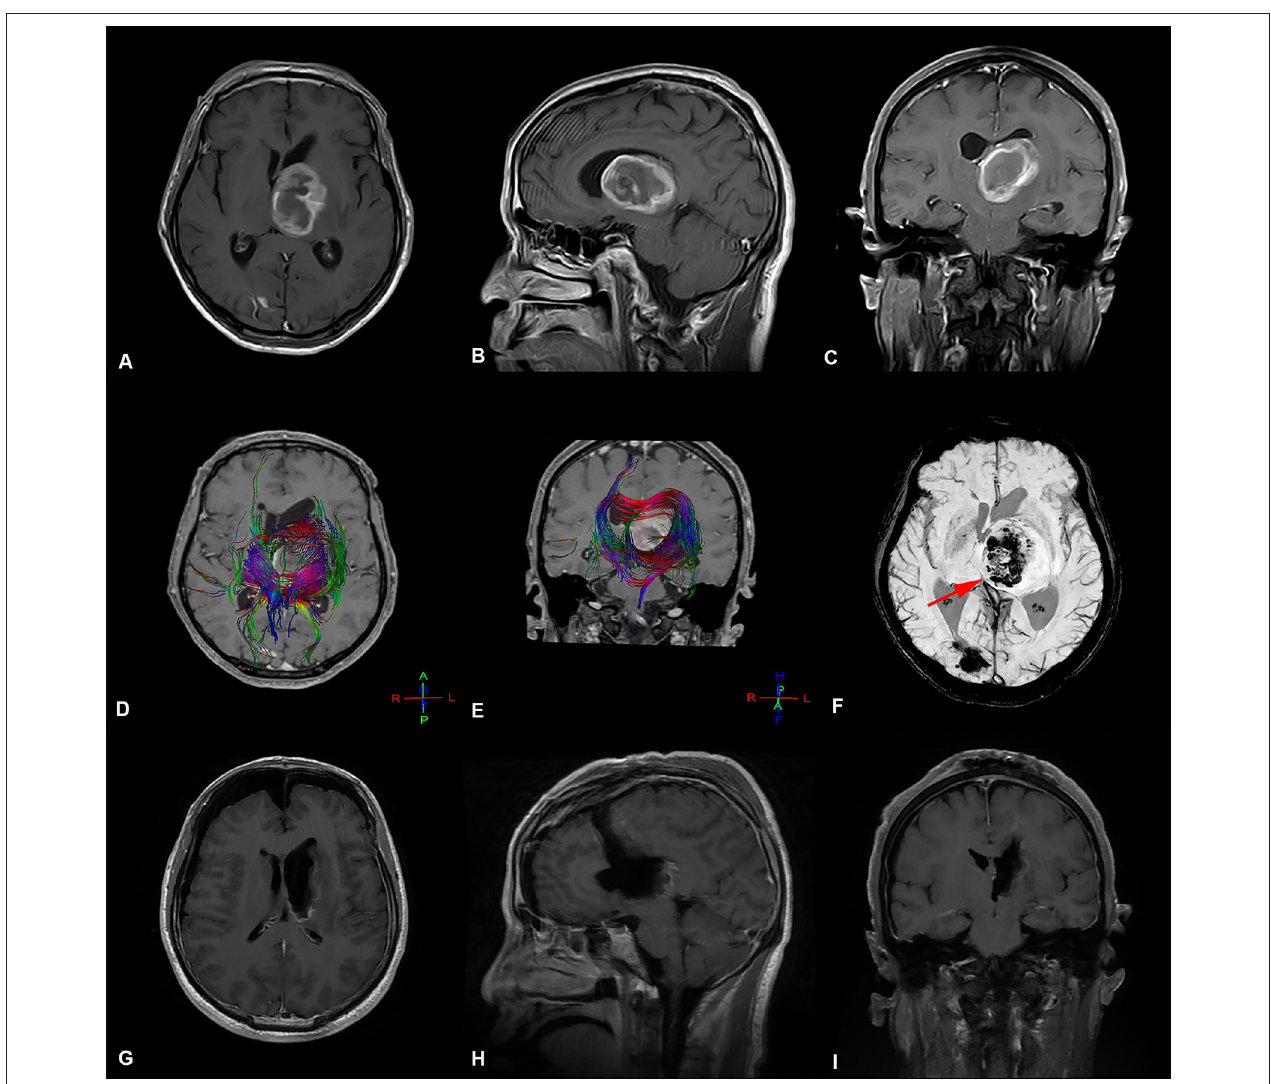
FIGURE 1 | Preoperative and postoperative imaging of thalamic malignant tumor resection with trans-frontal lateral ventricle approach. (A-C) display: Axial, sagittal, and coronal enhanced MRI of malignant tumors of the left thalamus. The main body of the tumor is located in the thalamus, pushing the surrounding normal structure, supratentorial lateral ventricle expansion, and the third ventricle pushing to the right. (D,E) display: The bundle of fibers passing through the left thalamus is destroyed and pushed by the tumor. (F) The deep cerebral vein (great cerebral vein ) is located at the ventral and posterior side of the tumor and is pushed to the right by the tumor (G-I) display: MRI images obtained after thalamic tumor resection via the trans-frontal lateral ventricle approach. The images show that the volume of ventricles did not increase or expand after total tumor